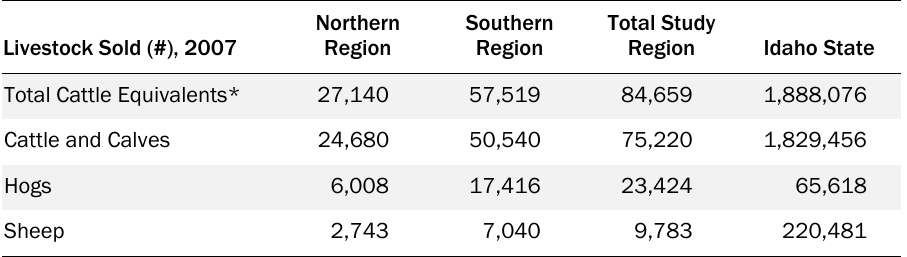
Table 2. Number of Livestock Sold in 2007 in the Study Region and Idaho State Northern Livestock Sold (#), 2007 Total Cattle Equivalents*